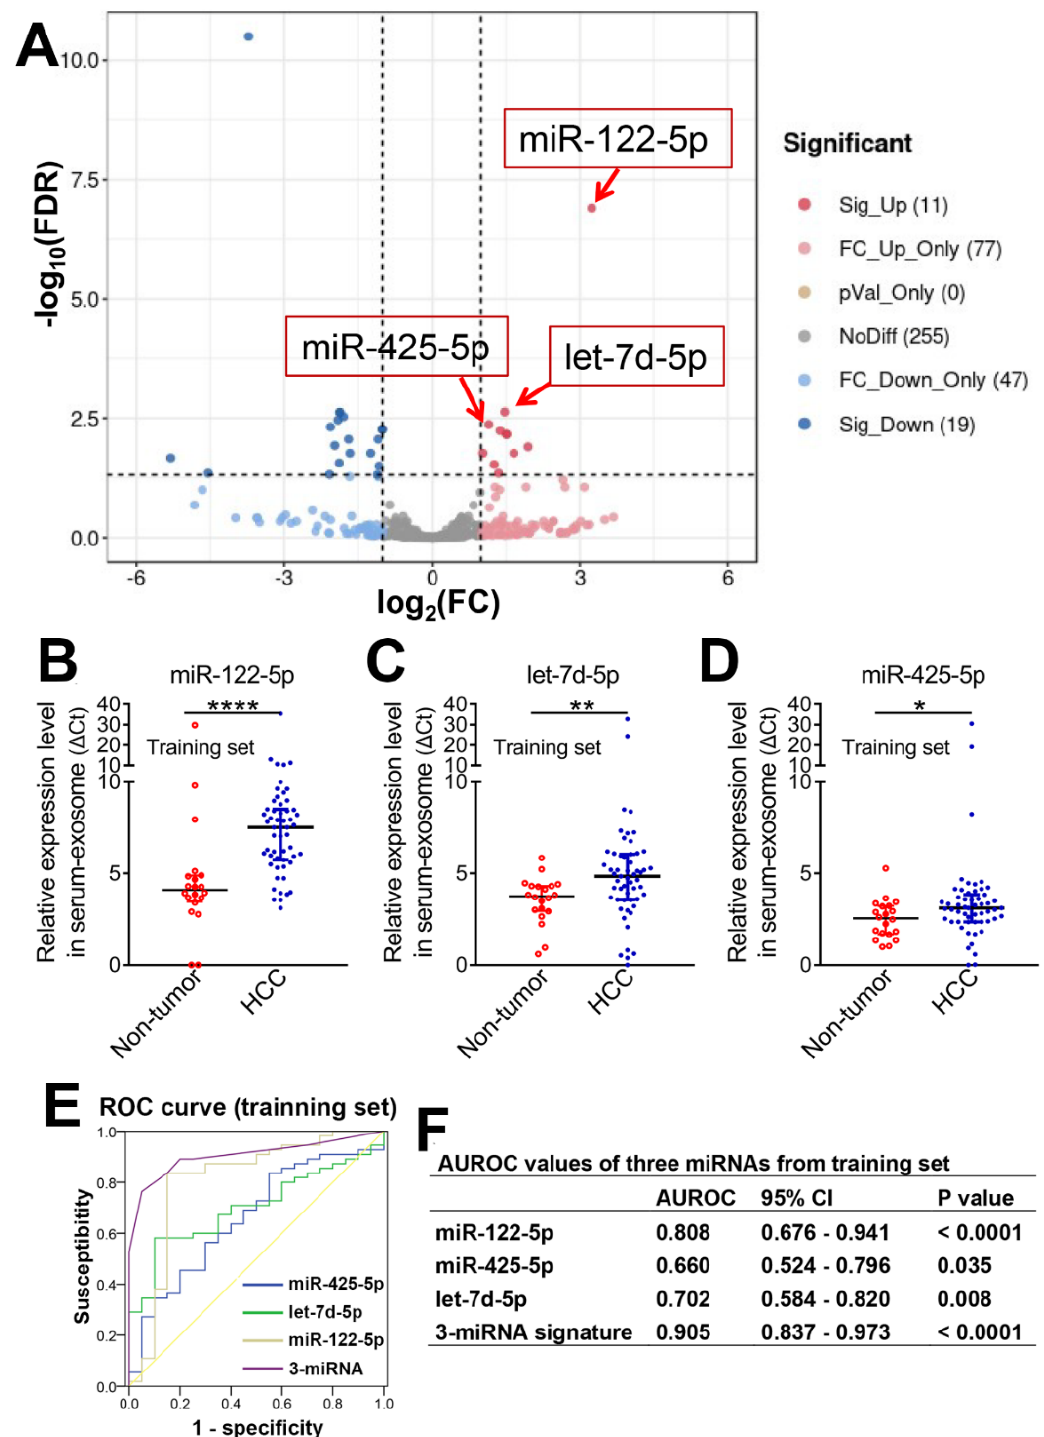
Figure 3. The training set detects that three serum-exosome-derived miRNAs can be used for diagnosing HCC. ( A ): The volcano plot shows the differentially expressed serum-exosome-derived miRNAs in HCC patients compared with non-tumor donors. Data are from the small RNAs sequencing. ( B – D ): The expression levels of the three serum-exosome-derived miRNAs in the training set (55 HCC patients and 20 non-tumor donors). ( B ): miR-425-5p; ( C ): let-7d-5p; ( D ): miR-122-5p. ( E,F ): The area under the receptor-operated curve (AUROC) depicts the values of the three serum-exosome-derived miRNAs in the diagnosis of HCC in the training set. *, **, and **** were used to represent p value of < 0.05, < 0.01, and < 0.0001, respectively.